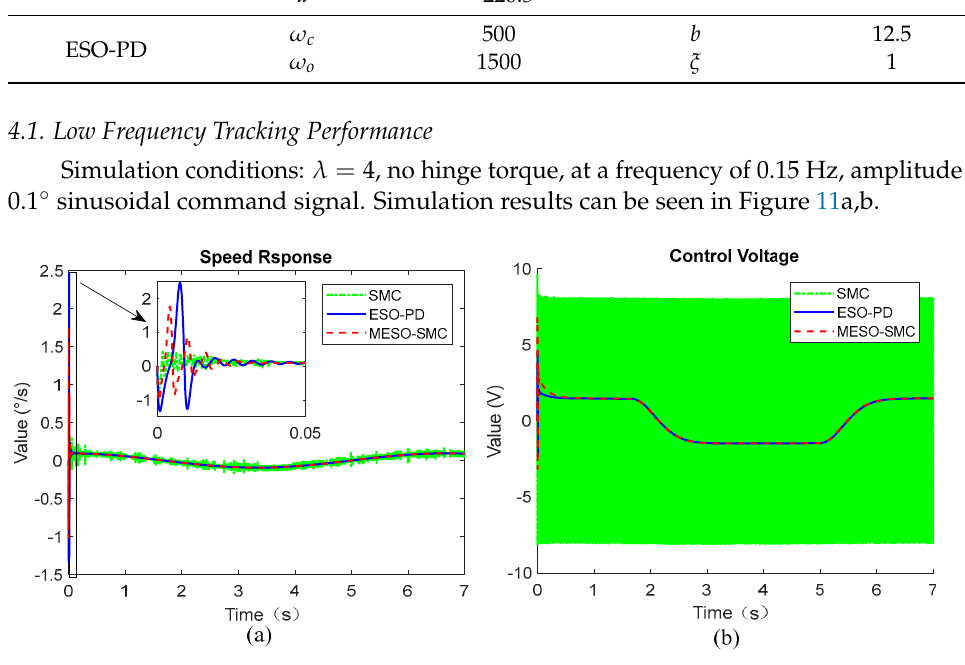
Figure 11. Speed and control voltage comparisons. ( a ) Speed response. ( b ) Control voltage.